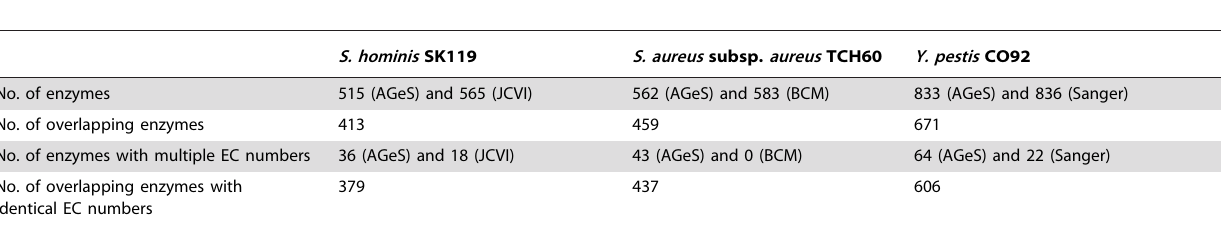
Table 4. Comparison of enzyme protein function (EC number) predictions between AGeS and other annotation methods for the three analyzed